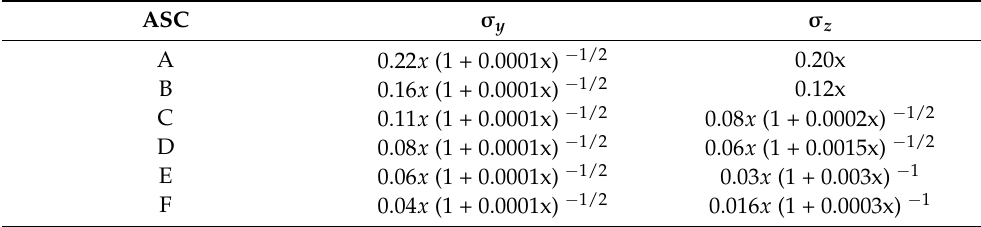
Table 3. Pasquill–Gifford dispersion coefficients of Briggs’s